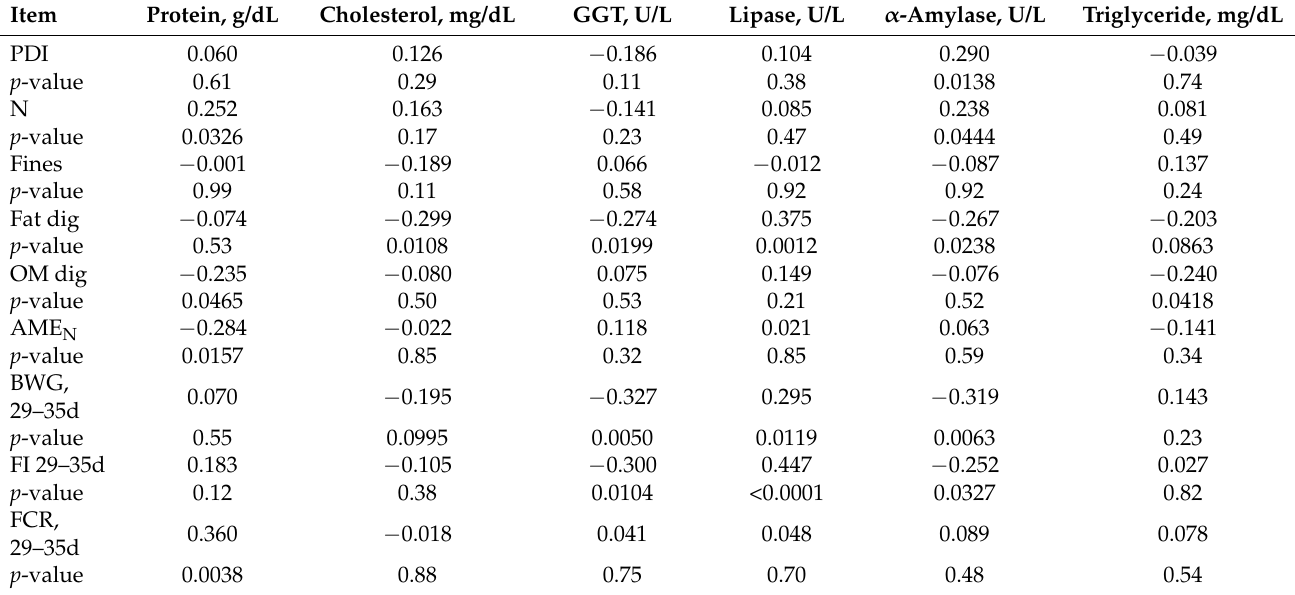
Table 16. Pearson’s correlations between feed physical proprieties, performance, and blood serum variables of broilers slaughtered at 36 days of